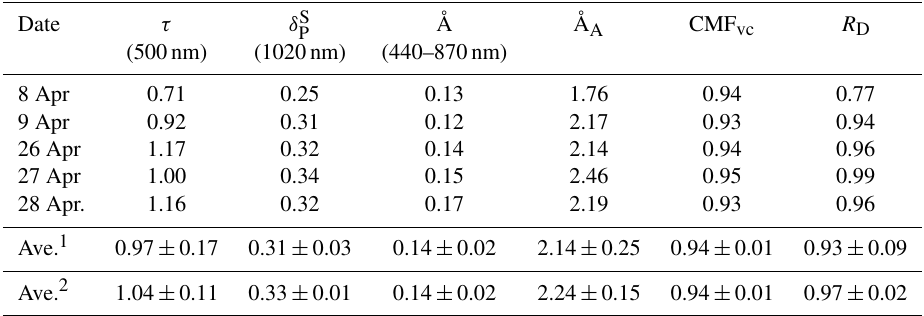
Table 3. Aerosol optical depth ( τ ) at 500nm, linear particle depolarization ratio ( δ S related Ångström exponent (Å, 440–870nm), absorption-related Ångström exponent (Å A ), coarse-mode fraction in terms of the volume concentration (CMF vc ), and dust ratio ( R D ) at 1020nm. The observation site is Dunhuang.